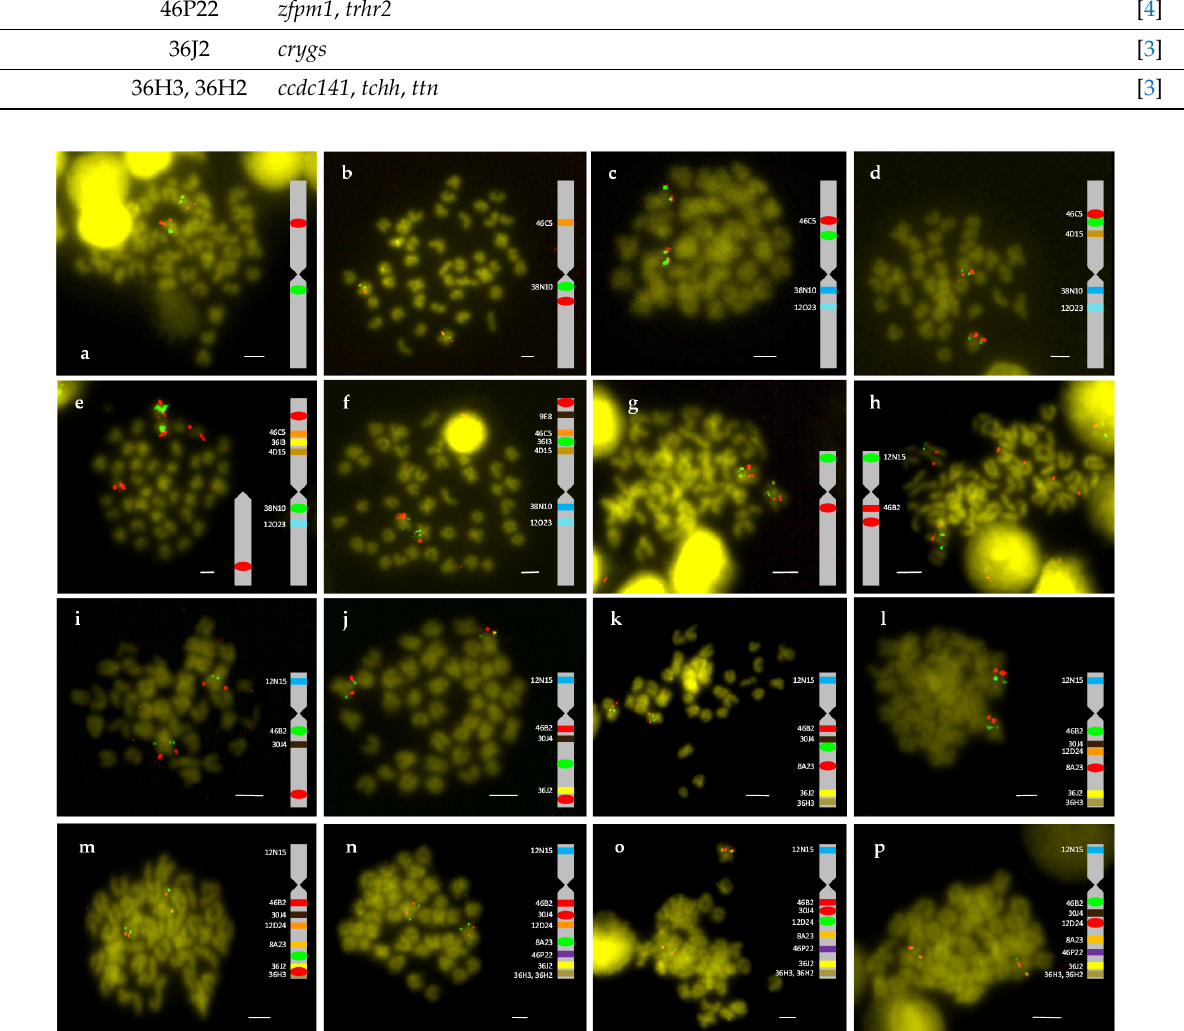
Figure 1. Double FISH-BAC of chromosome 2 ( a – f ) and chromosome 4 ( g – p ). ( a ) 38N10 (green)/46C5 (red), ( b ) 38N10 (green)/21O23 (red), ( c ) 4D15 (green)/46C5 (red), ( d ) 36I3 (green)/46C5 (red), ( e ) 38N10 (green)/9E8 (red), ( f ) 36I3 (green)/52G10 (red), ( g ) 12N15 (green)/46B2 (red), ( h ) 12N15 (green)/30J4 (red), ( i ) 46B2 (green)/36J2 (red), ( j ) 8A23 (green)/36H3 (red), ( k ) 12D24 (green)/8A23 (red), ( l ) 46B2 (green)/8A23 (red), ( m ) 46P22 (green)/36H2 (red), ( n ) 8A23 (green)/30J4 (red), ( o ) 12D24 (green)/30J4 (red), and ( p ) 46B2 (green)/12D24 (red). Bar = 2 µ m (referred to large metacentric chromosome